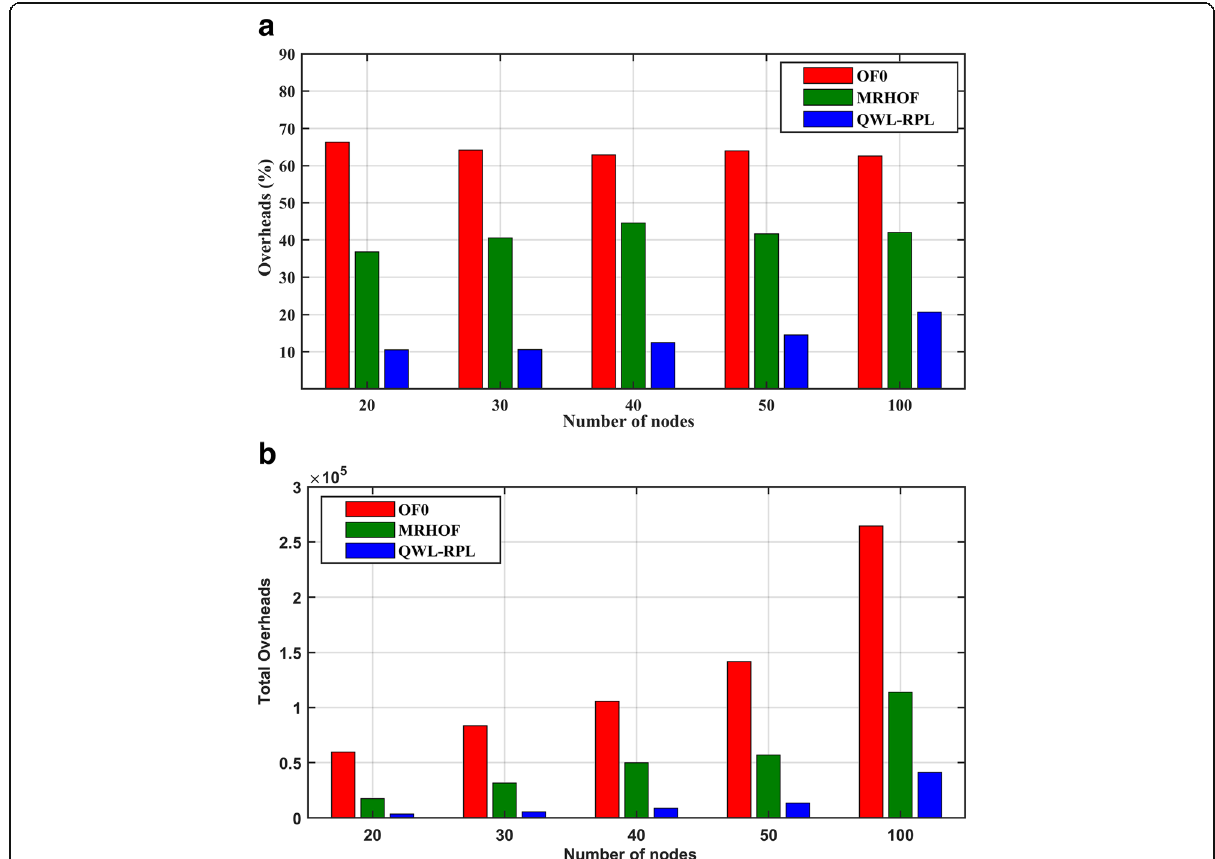
Fig. 13 Simulation analysis for scenario I for the a overheads (%) and b the total number of overheads versus number of